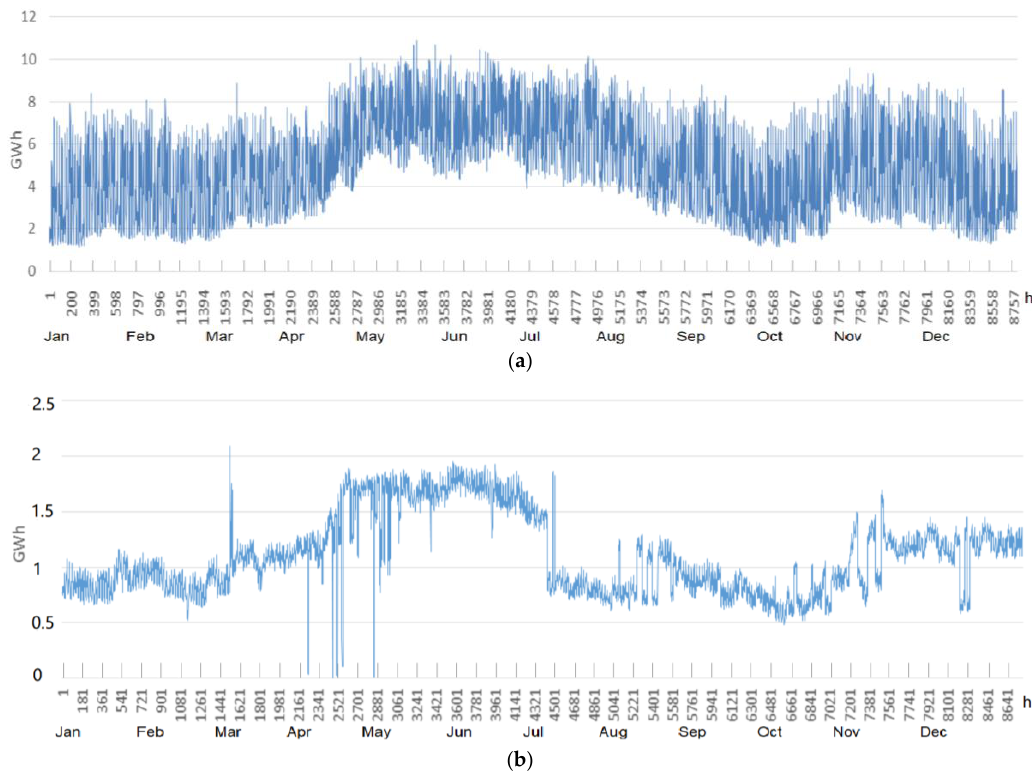
Figure 8. Hourly distribution of ( a ) dammed and ( b ) river hydropower production in Italy.